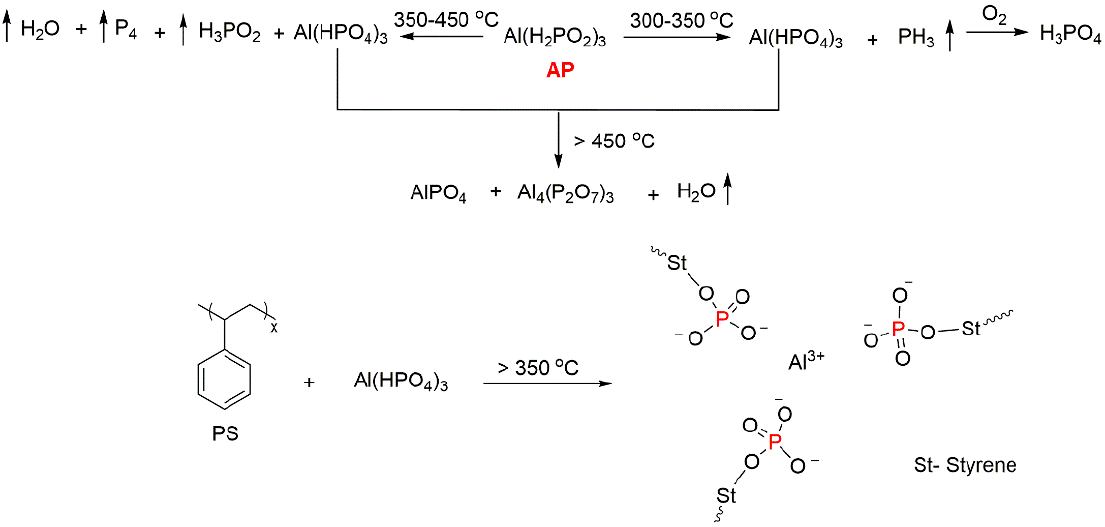
Figure 7. Fire-retarding mechanisms occurring within PS/AP (aluminium hypophosphite) composites